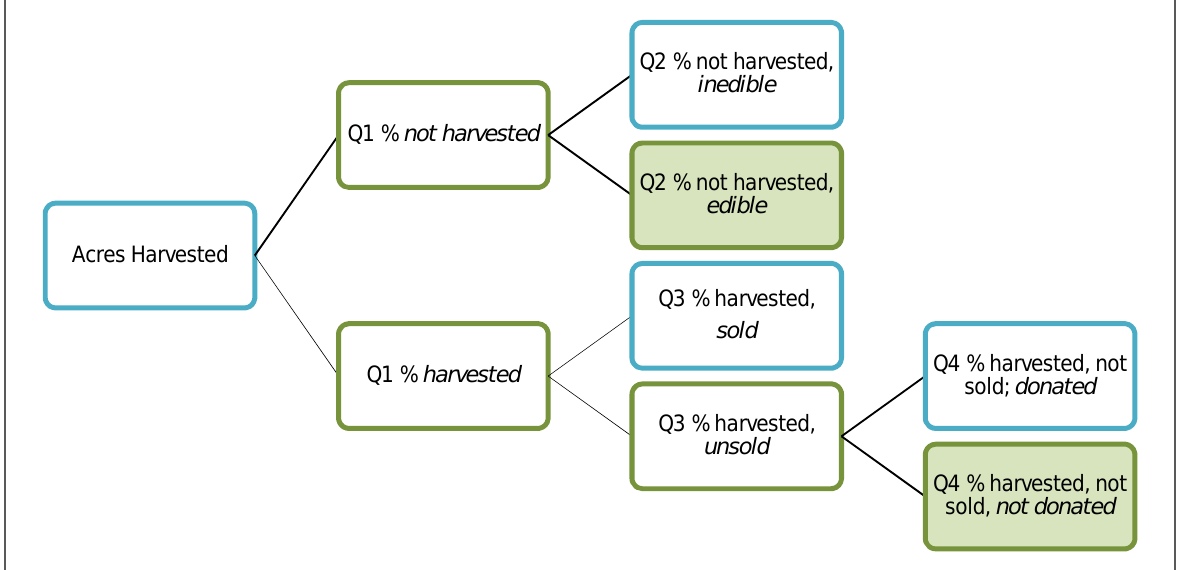
Figure 2. Schematic of Method Applying Survey Responses to Estimate Salvageable